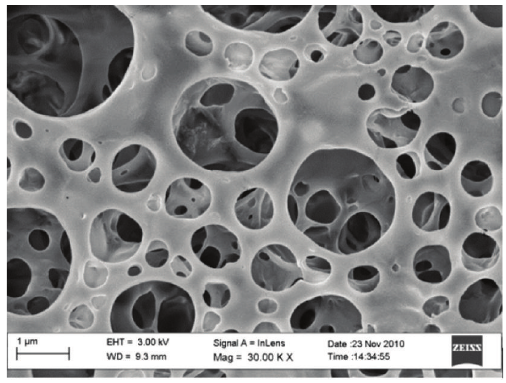
Figure 2: SEM image of the surface of a PHB film made with 10% of water in the emulsion template taken with in-lens detection mode. The scale bar is 1 𝜇 m and the magnification is × 30 k.